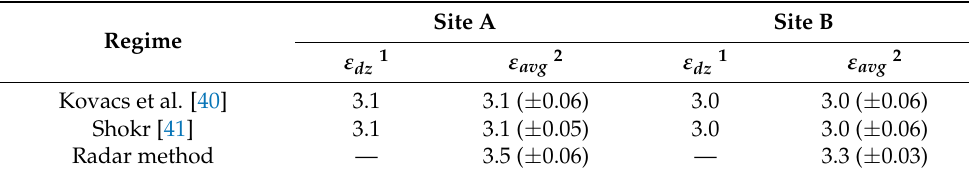
Table 1. The dielectric permittivity of river ice at Site A and Site B on 15 February 2014, as calculated using three different methods.